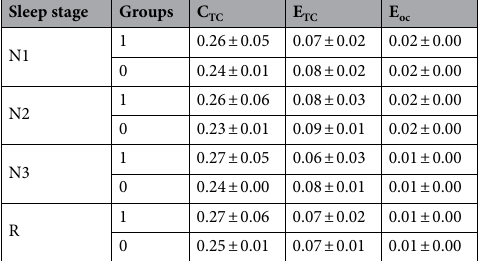
that of OSA_withoutOH, while the transition probability from microstates A, B, C, D to E was less than that of OSA_withoutOH, as shown in Fig. 3. This indicated that the microstates A, B, C, D and E transferred to micro- states C with a high probability, and to E with a low probability after the occurrence of obstructive hypopnea. Power, sample entropy and DFA of OSA patients. The power, sample entropy and DFA of OSA_OH vs. Control and OSA_OH vs. OSA_withoutOH were respectively analyzed by 2 × 7 multivariate ANOVA, show- ing significant differences. Then, a two-sided one-sample t test was conducted within group, as shown in Figs. 4 and 5. For OSA_OH vs. control, there was a significant difference in beta power in N1 (P = 0.026), in sigma power in N2 (P = 0.02), in delta, theta and alpha power in N3 stage (P = 0.021; P = 0.027; P = 0.007), in beta power in R (P = 0.021). For OSA_OH vs. OSA_withoutOH, there was a significant difference in beta power in N2 (P = 0.02), in beta power in N3 (P = 0.04), in theta power in R (P = 0.016).